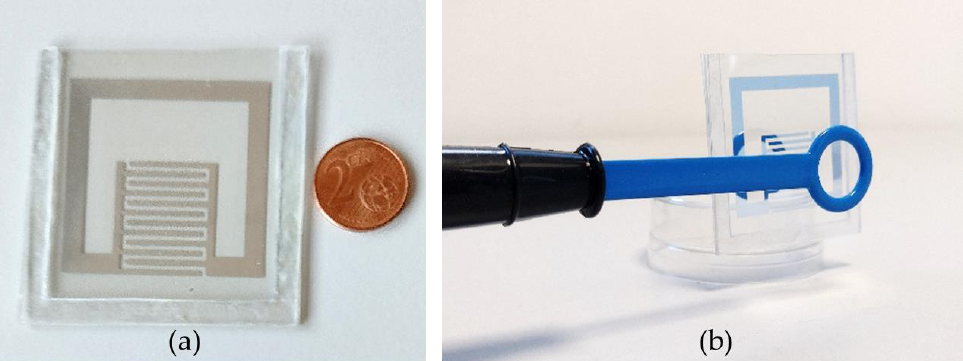
Figure 3. ( a ) Polycarbonate sampling cell with an embedded resonator. The metallic resonator is on the internal wall of the sampling cell. ( b ) Configuration of the non-contact RF-detection system.